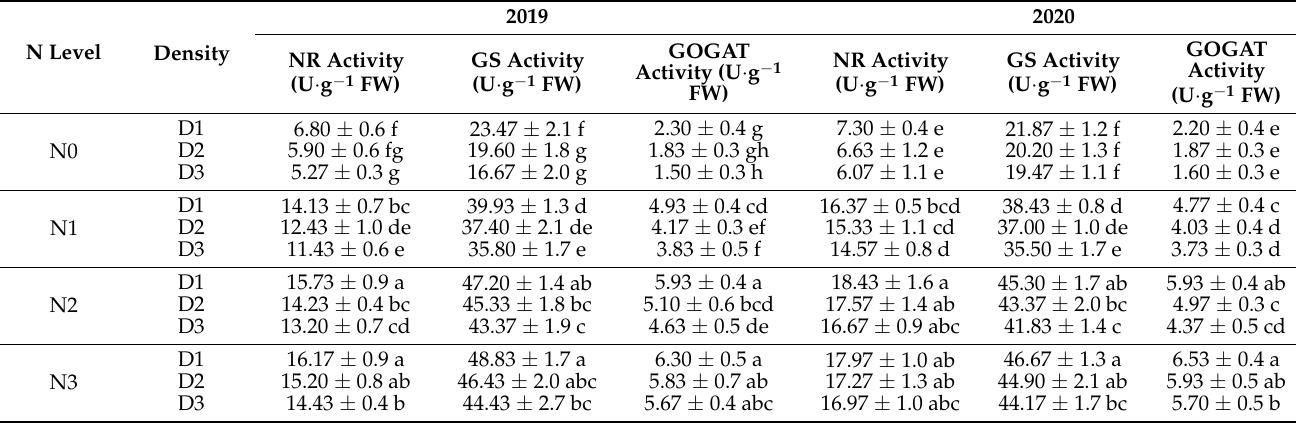
Table 8. The interaction of increasing density and decreasing N on nitrogen assimilating enzymes activities at flower- ing stage.